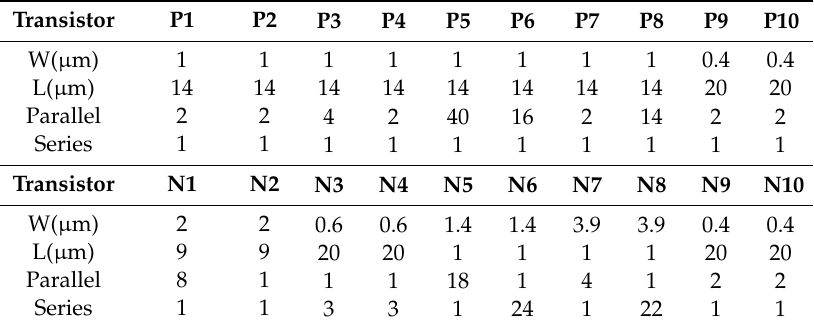
Table 3. Transistor dimensions of the proposed voltage